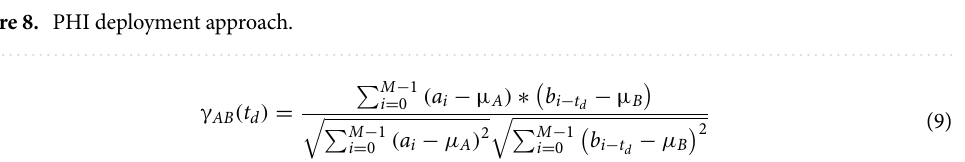
Figure 8. PHI deployment